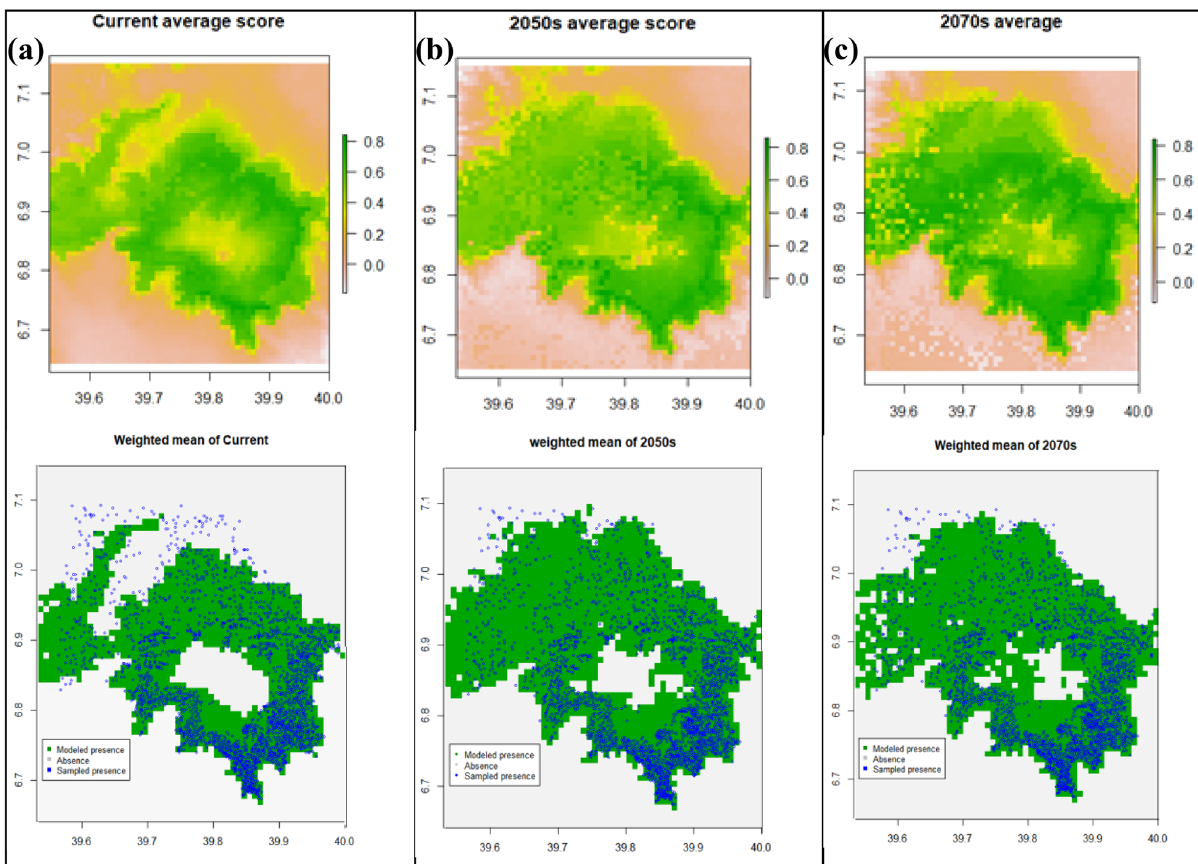
Figure 9. Ensemble four models’ average of the three-time steps (Current, 2050s, and 2070s), and their respective presence/absence maps compared with sampled presence sampling points. A gray area represents absolute absence (unsuitable habitat), green indicates modeled presence (suitable habitat), while blue circles represent sampled presence